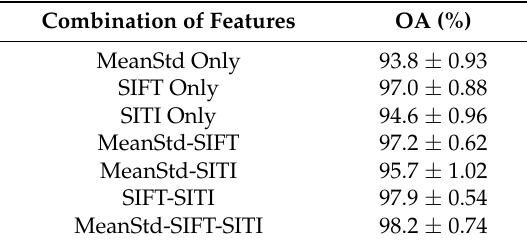
Table 4. Classification accuracy values based on AI-MFLDA with different combinations of features on the four-class aurora image dataset.